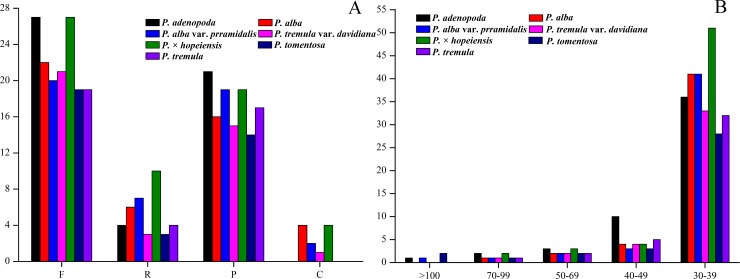
Analysis of repeat sequences in the seven cp genomes.(A) Frequency of repeat types. Forward repeat (F), reverse repeat (R), palindrome repeat (P) and complement repeat (C). (B) Frequency of repeats ≥30 bp in length.